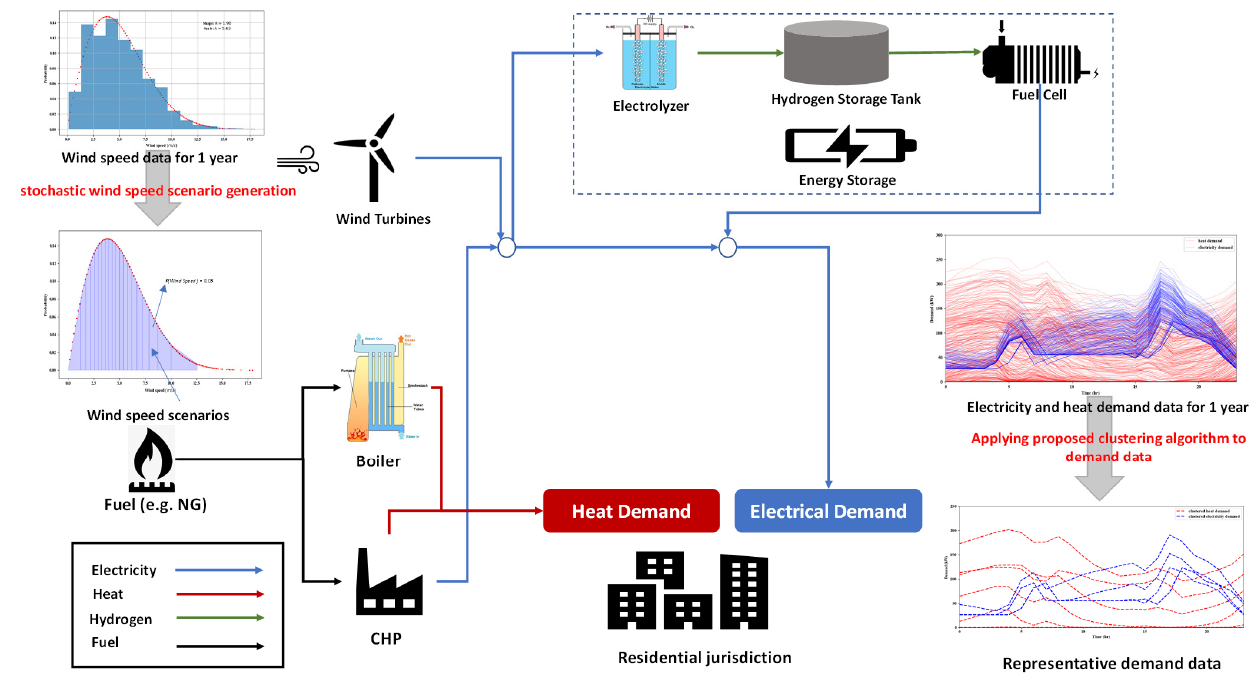
Figure 6. Understudy energy hub architecture.